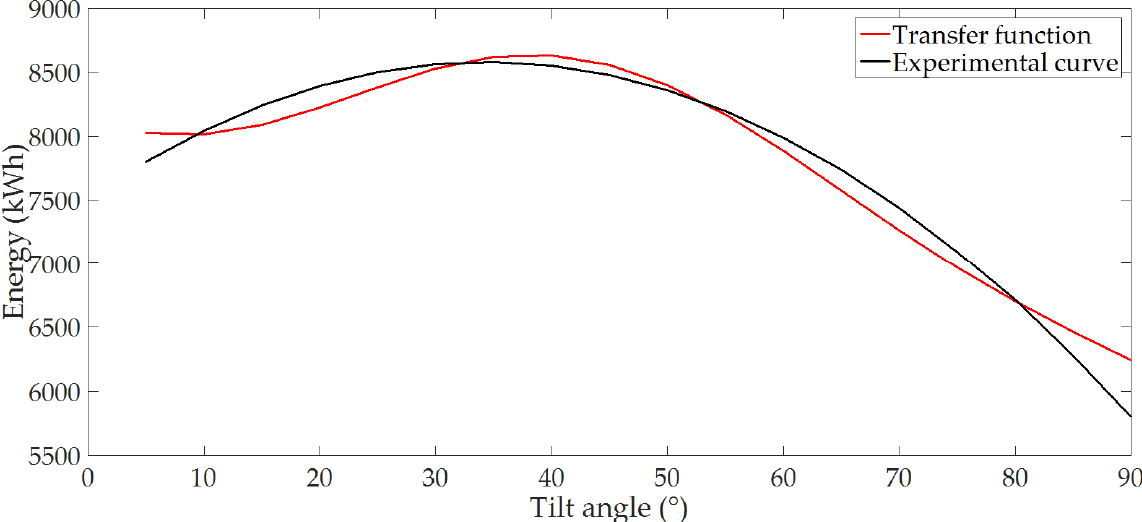
data was determined (Figure 8).